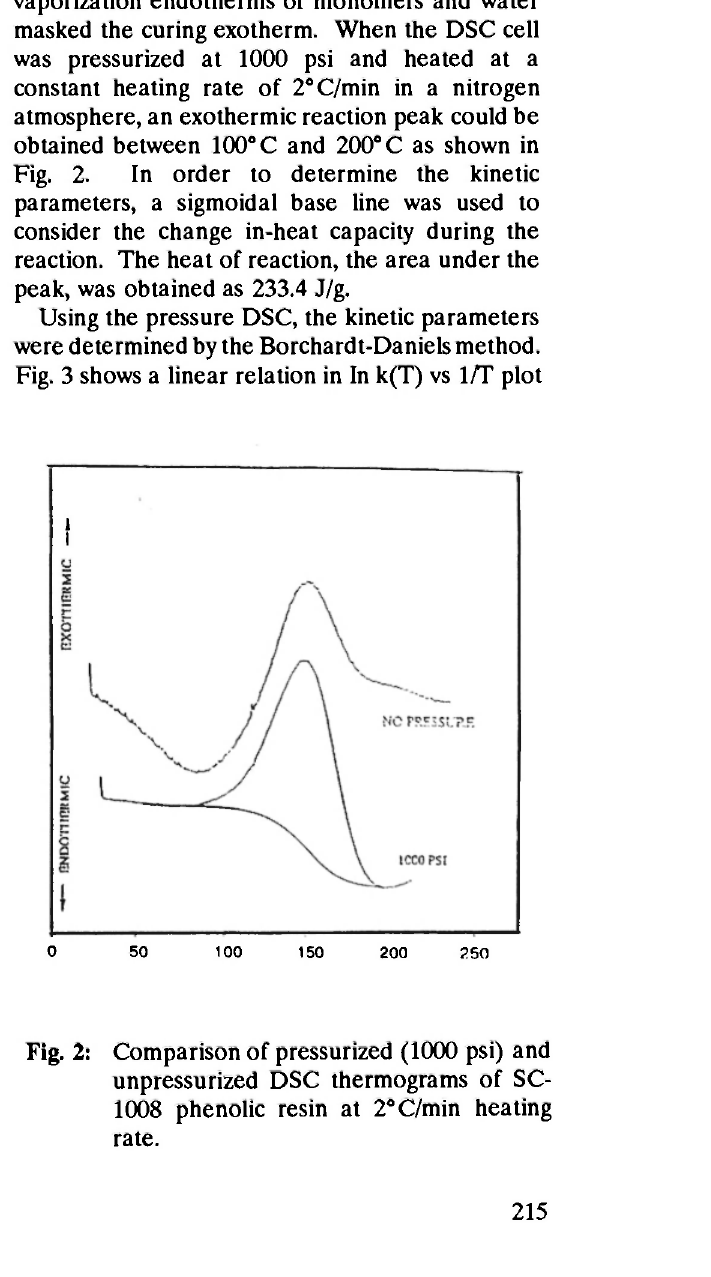
Fig. 2: Comparison of pressurized (1000 psi) and unpressurized DSC thermograms of SC- 1008 phenolic resin at 2°C/min heating